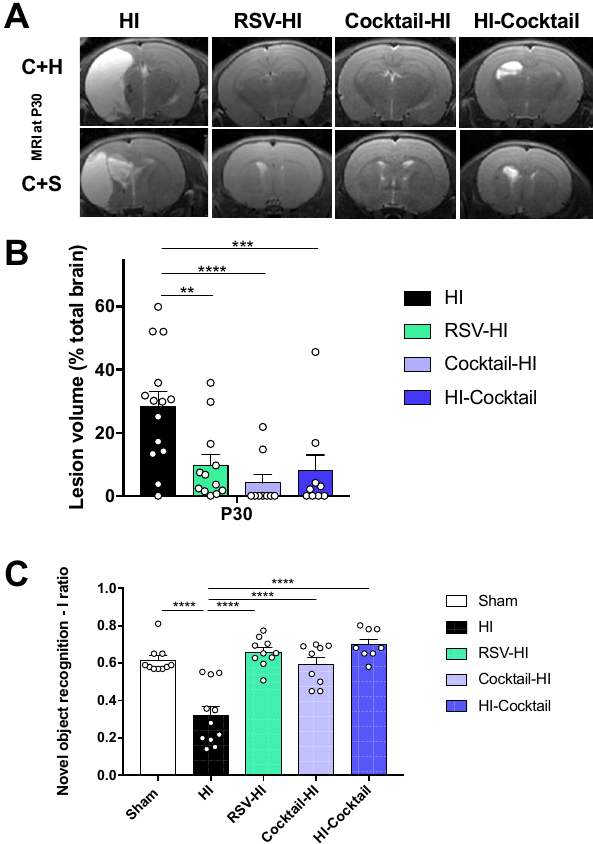
Figure 5. Evaluation of the lasting neuroprotection provided by maternal supplementation. ( A ) Typical T2 for each group (P30). Images centered on the cortex + hippocampus (C + H) and cortex + striatum (C + S) areas are shown. ( B ) Brain lesion volumes quantification (% total brain volume) at P30 (23d post-HI) ( C ) Novel object recognition discrimination index for sham, HI, RSV-HI, Cocktail-HI and HI-Cocktail groups. Discrimination I ratio was defined as: I = (time spent on new object-time spent on familiar object)/(time spent on new object + time spent on familiar object). * Significant difference between 2 groups: ** p < 0.01, *** p < 0.001, **** p < 0.0001). HI, hypoxia-ischemia. RSV, resveratrol.